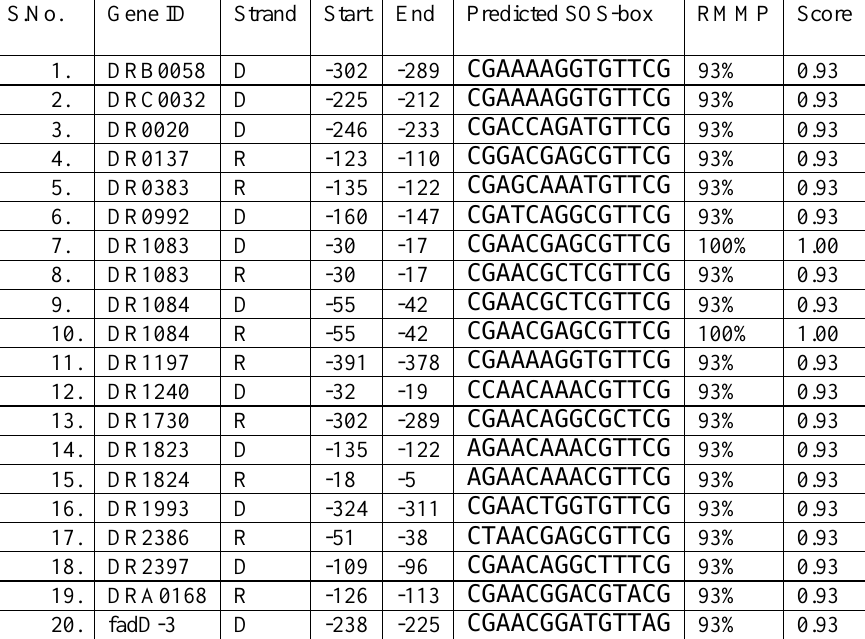
Supplementary Table 15 (S15): Genome wide detection of known B. subtilis SOS-box (CGAACRNRYGTTCG) in the upstream sequences (-400 bp) of D. radiodurans through direct pattern matching method alone. Only 18 genes were identified.